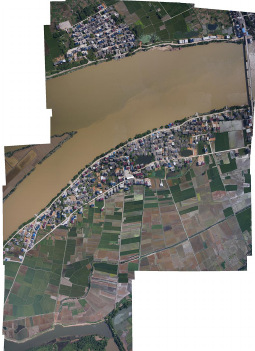
Figure 10. A complete full coverage area map based-on improved